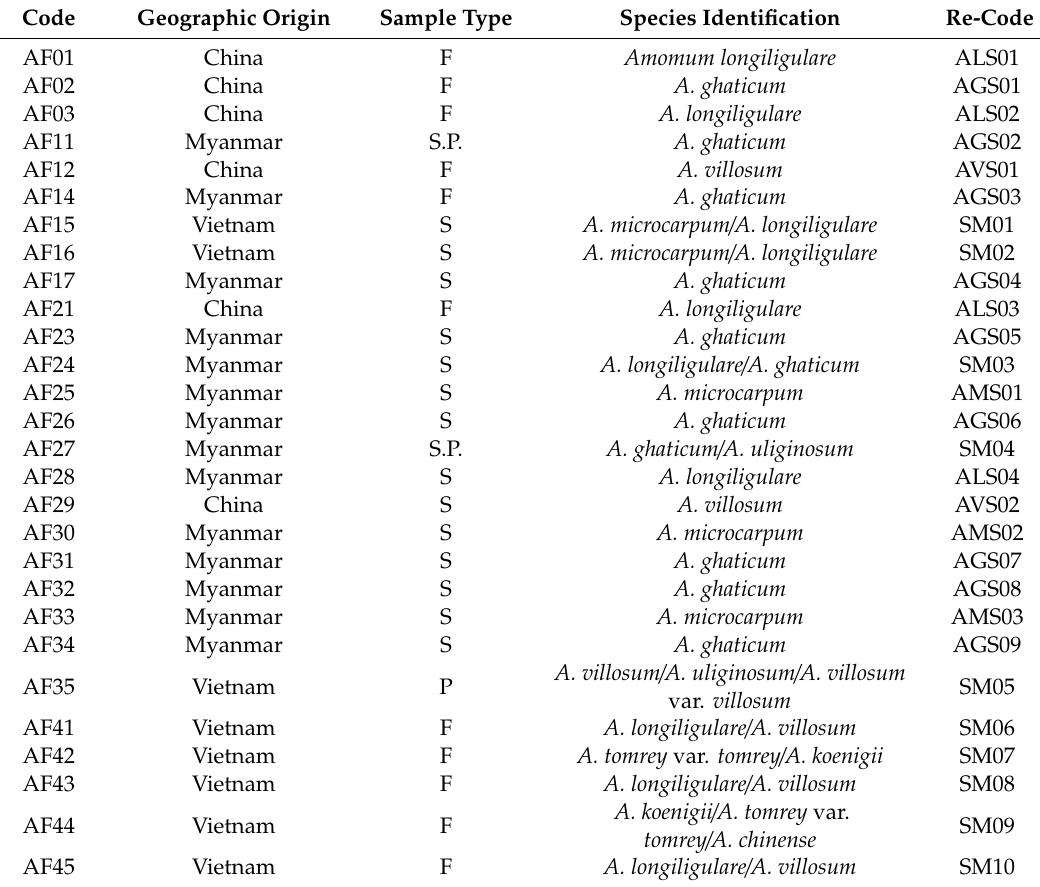
Table 1. Amomi Fructus samples identified using DNA barcode analysis of the internal transcribed spacer (ITS)